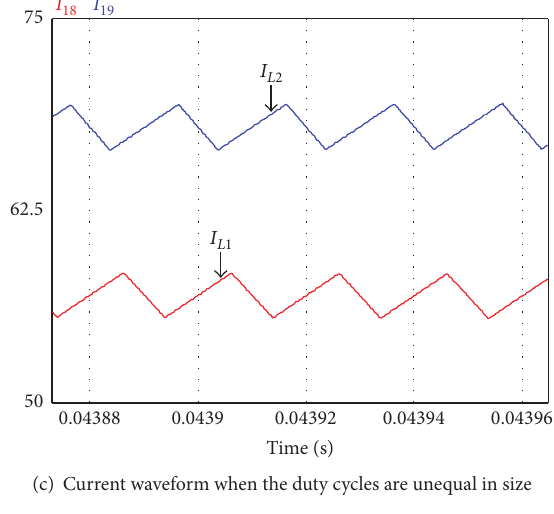
Figure 5: Inductor current simulation